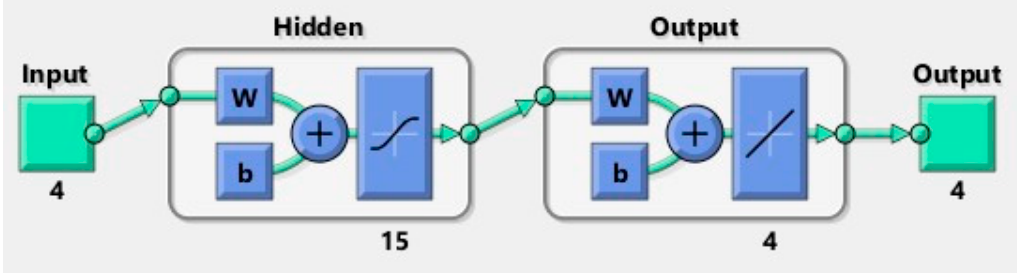
Figure 5. Basic structure of the developed MLP network.